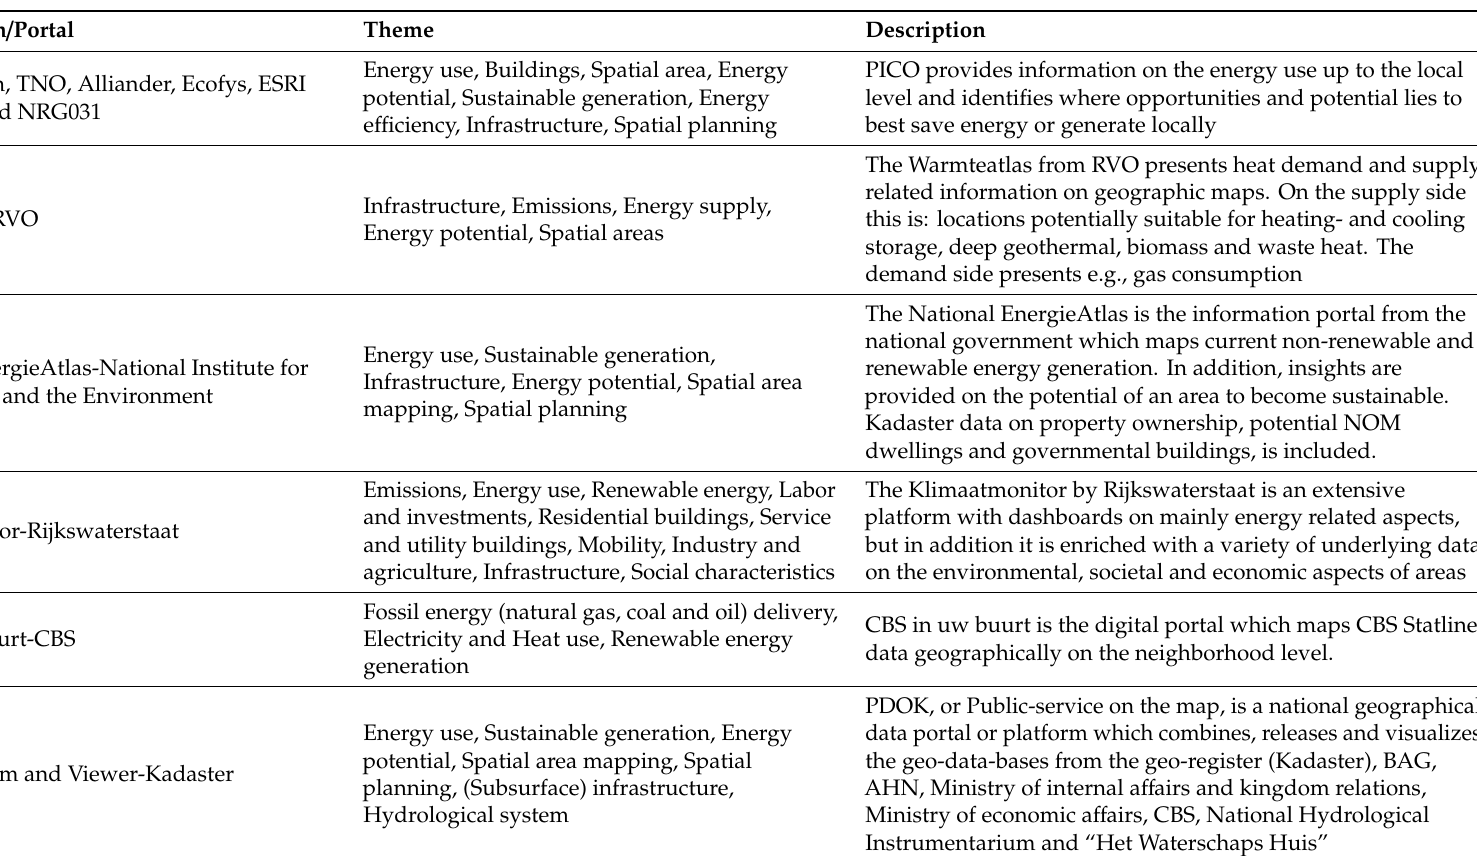
Table A3. Overview of data platforms or portals that can be utilized for urban thermal energy system decision-making in the Netherlands; clicking on the platform name directs the reader to the online